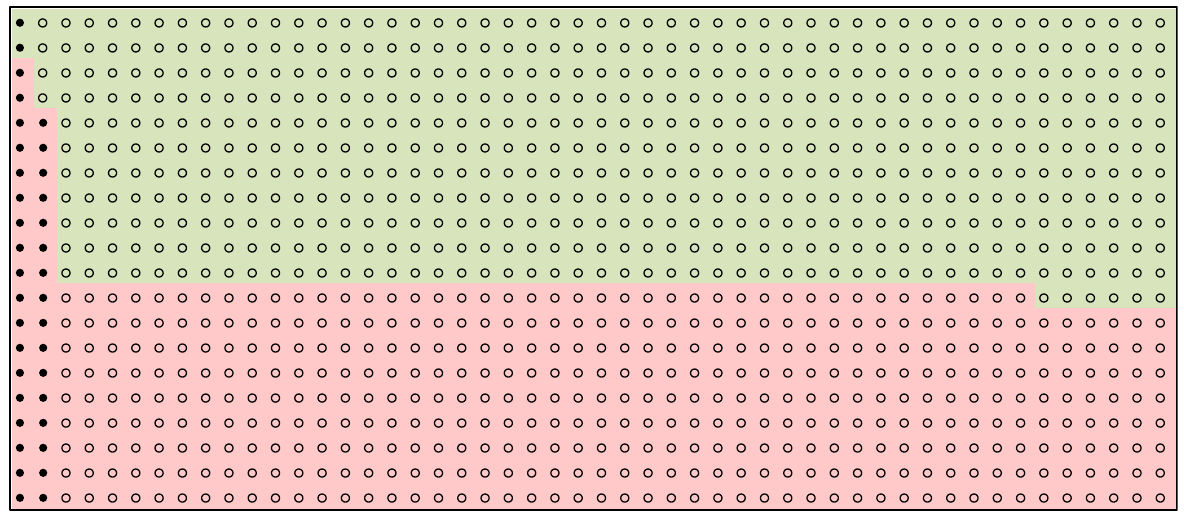
Fig. 1 Population diagram to illustrate clinical ramifications of the Canadian Syncope Risk Score for acute management of syncope (cut-point “ low risk ” ). Each circle in the figure represents one person (1000 in total) presenting in the emergency department with syncope, of whom approximately 36 will sustain a serious adverse event (shaded circle) and 964 will not (unshaded circle). Red cells (460) indicate people deemed “ at risk ” using the risk score with a cut-point of “ low risk ” . Green cells are people deemed not “ at risk ” . These natural frequencies are derived from the reported sensitivity of 93%; specificity 56% (for the low-risk cut-point); and prevalence (0.036) in the internally validated model [30]. The internally validated C-statistic for the developed model was 0.88 (95%CI 0.85, 0.90).